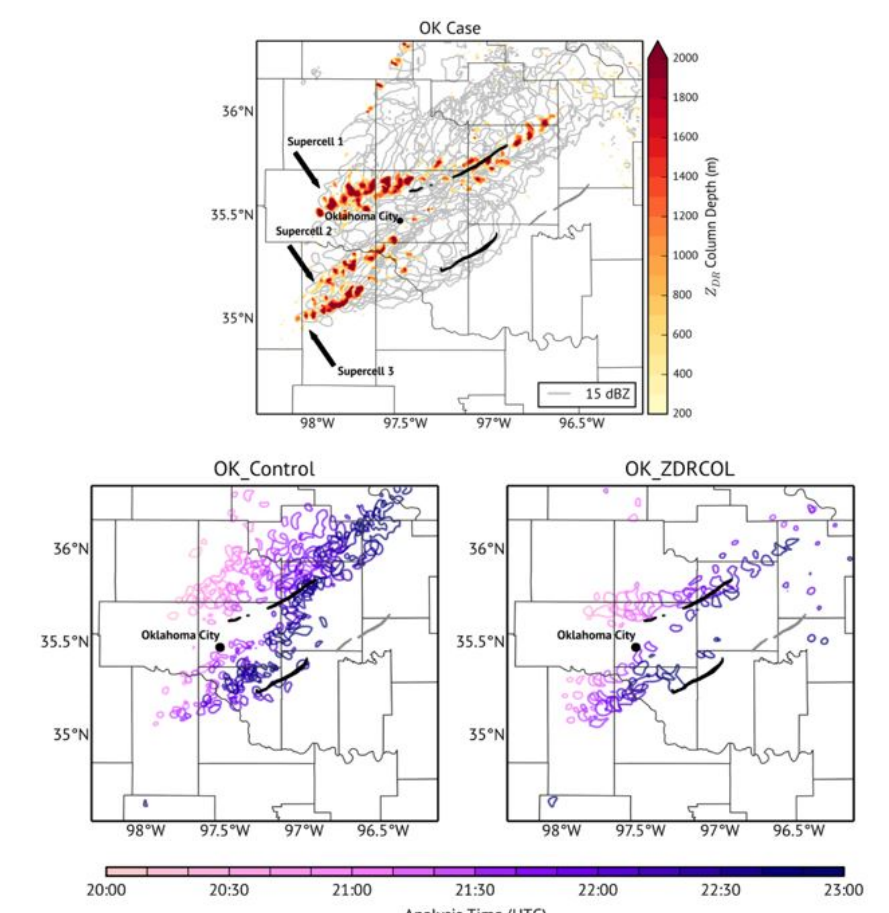
Figure 19. ( Top panel ) Composite remapped Z (15-dBZ contour in gray) and analyzed Z DR column depth (color shaded as m and defined as the height of the 1-dB surface above the environmental 0 ◦ C level) between 2000 and 2300 UTC in 10-min intervals for the 19 May 2013 storm in Oklahoma. Observed tornado tracks are shown in black and grey, with grey tracks indicating observed tornadoes that fall outside of the period of study. ( Bottom panels ) Composite maximum vertical velocity in each grid column for each of the post-assimilation analyses from 2000 to 2300 UTC without using polarimetric information (left bottom panel) and utilizing the Z DR column height (right bottom panel). Blue contours show 30 m s − 1 vertical velocity contour lines with color intensity depending on the analysis time. Adapted from Carlin et al.